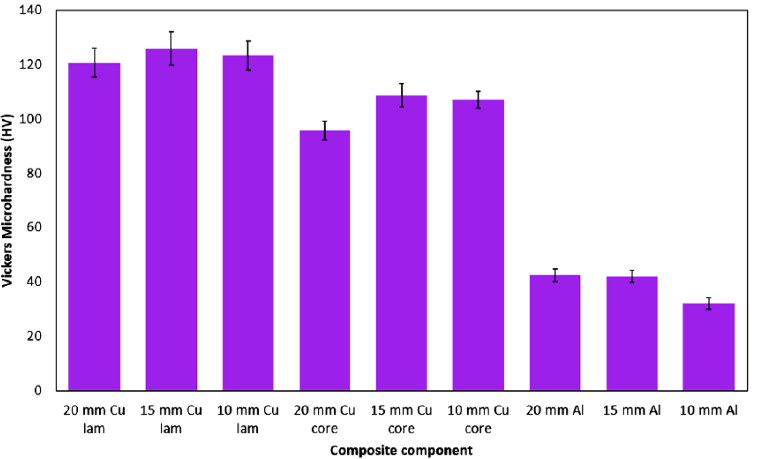
Figure 11. Vickers microhardness for individual components of swaged composites.